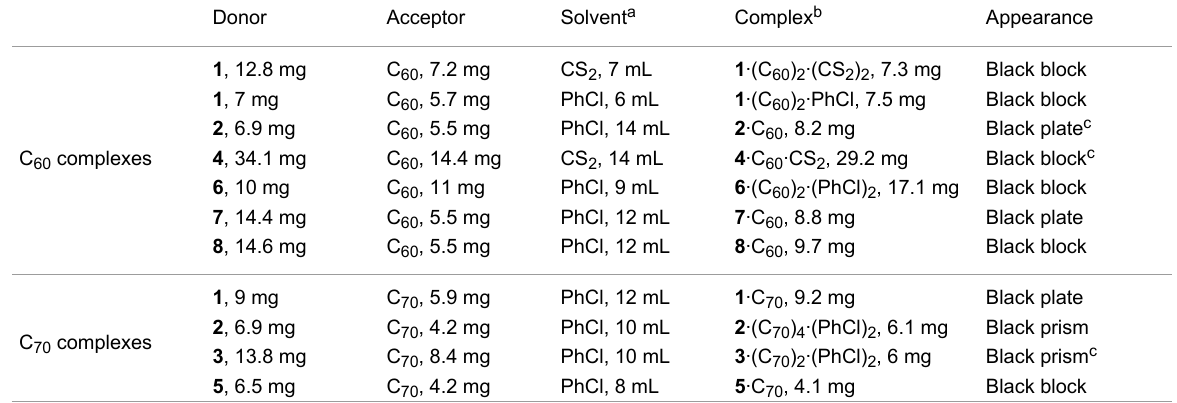
Table 1: Experimental conditions for the preparation of the